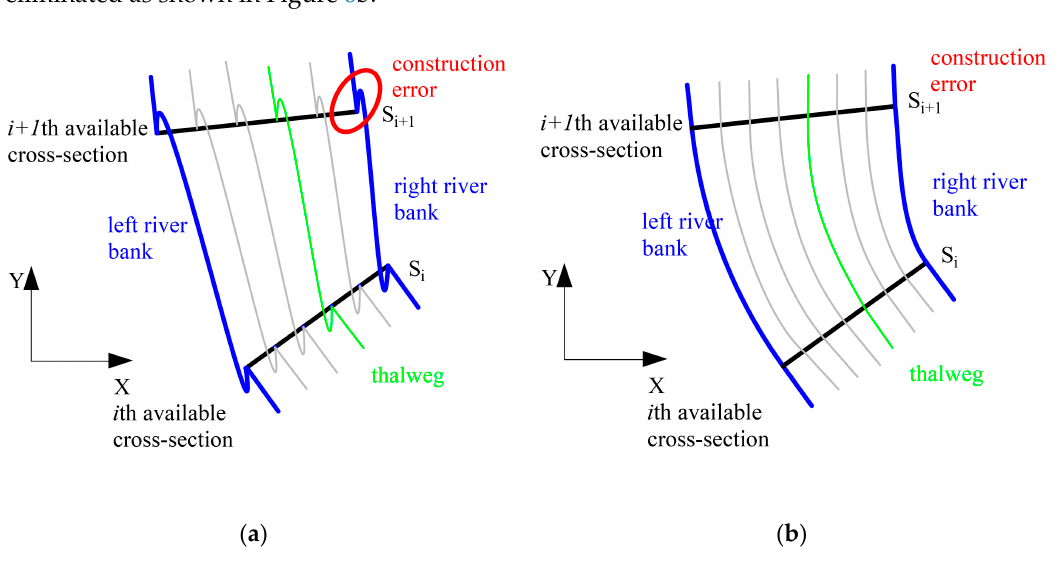
Figure 6. Constructing error and the treatment. ( a ) Constructing errors occurring by using the existing method; ( b ) the corrected river trend construction using the proposed QHSP method.